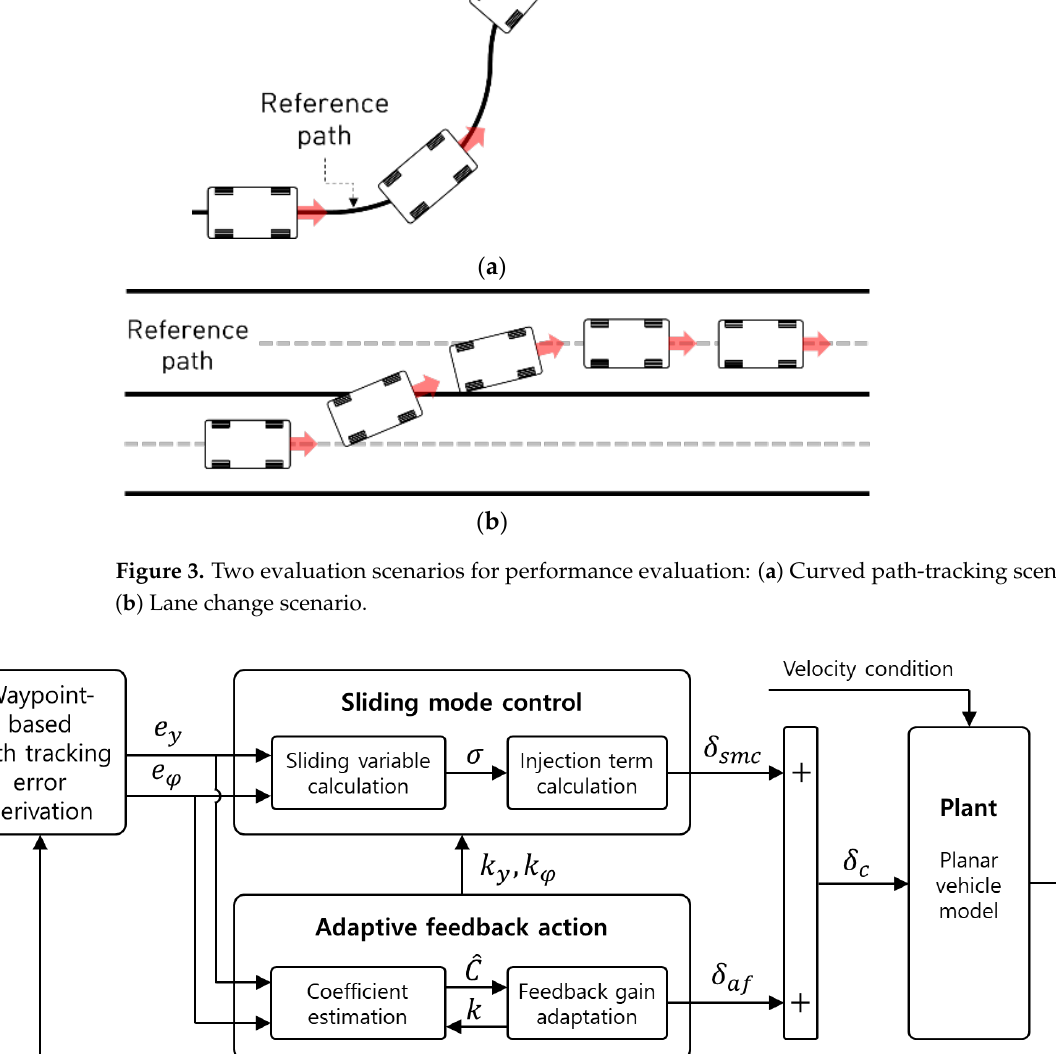
Table 2. Vehicle specification.